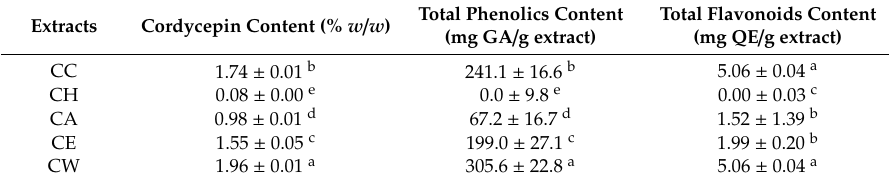
Table 2. Cordycepin, phenolics, and flavonoids content of C. militaris